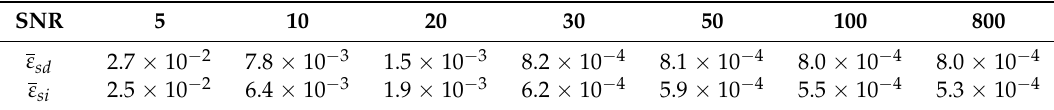
Table 2. Estimation errors of SD and SI noise on the synthetic HS image with various SNR values.